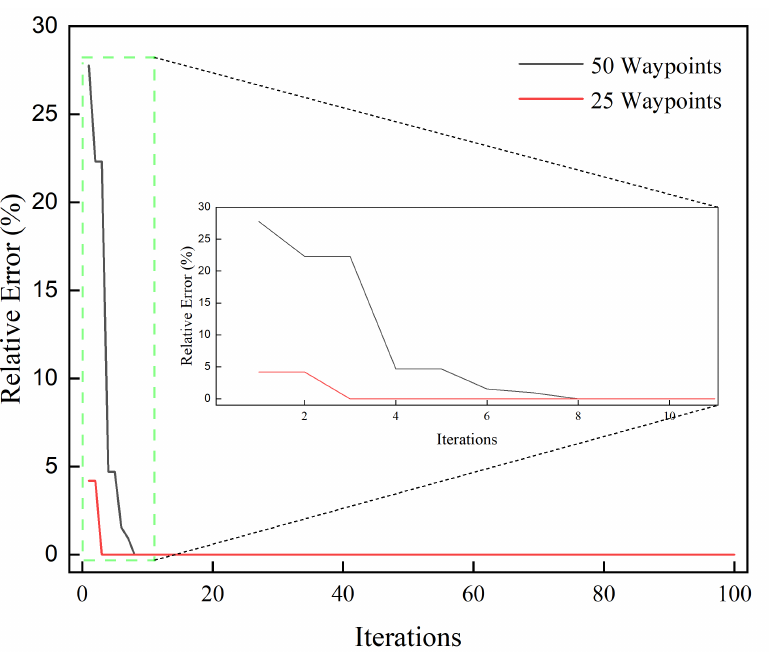
Figure 12. RE curves using the DGTOA for 25 and 50